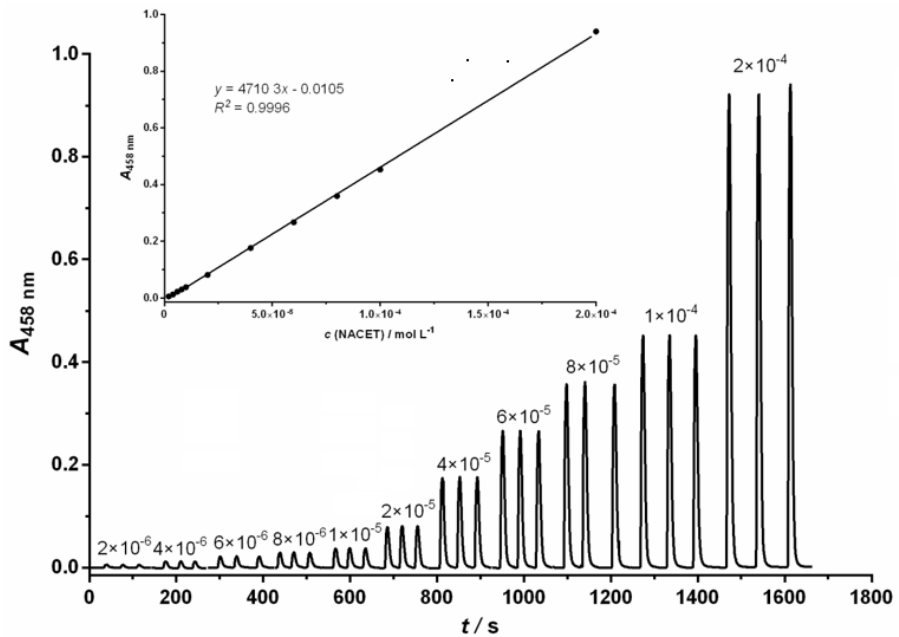
Figure 1. Diagram chart and calibration curve for spectrophotometric determination of NACET in